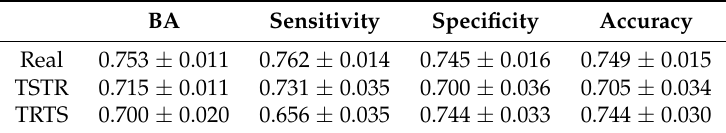
Table 3. Performance of 1-layer neural network for context recognition when: (a) both the training and the test sets are real (Real, first row); (b) a model trained with synthetic data and the test set is real (TSTR, second row); and (c) the training set is real and the test set is synthetic (TRTS, bottom